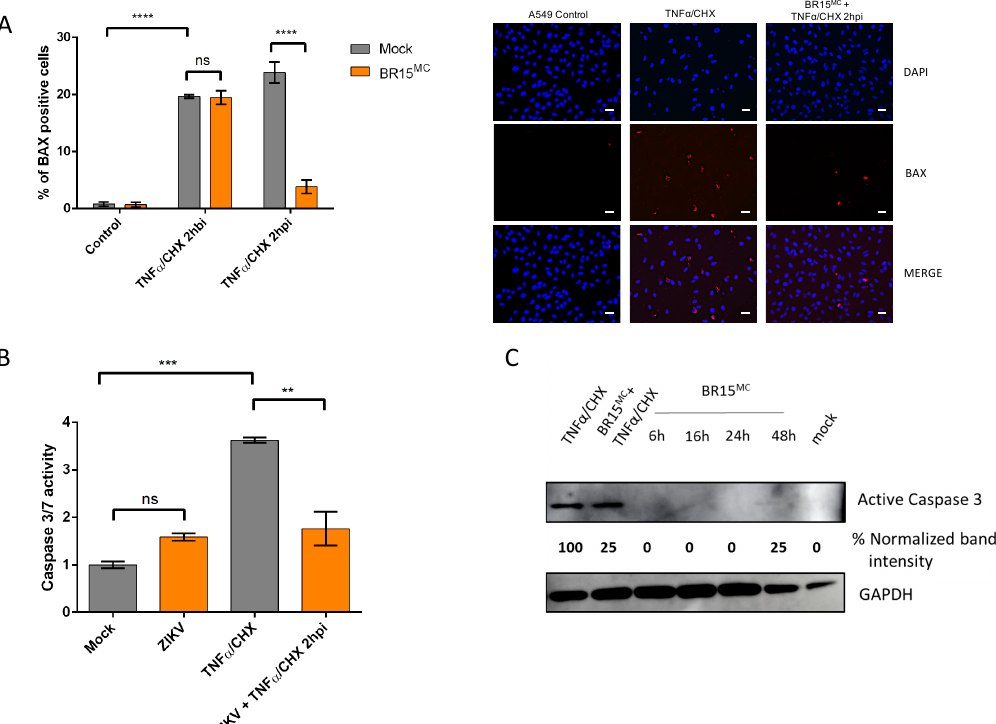
Figure 3. BR15 MC provides a protection against extrinsically induced cell death. A549 cells were infected with BR15 MC at MOI of 1 for 8 h and treated with TNF α and cycloheximide (TNF α / CHX) 2 h post infection (2 hpi) or 2 h before infection (2 hbi). ( A ) The percentage of A549 cells immunolabeled with anti-BAX antibody was enumerated from images representative of immunofluorescence observations (panels on the right, white scale bar: 10 µ m). ( B ) Caspase 3 / 7 activity was measured after TNF α / CHX treatment 2 hpi and normalized to mock treated and infected cells. ( C ) Immunoblot of active caspase 3 during TNF α treatment 2 hpi and infection time course with BR15 MC . Active caspase 3 band intensity was normalized with GAPDH. Western blotting (WB) is representative of three independent experiments. Values represent the mean and standard deviation of three independent experiments. Data were analyzed by a one-way ANOVA test with post-hoc Tukey’s test (** p < 0.01; *** p < 0.001, **** p < 0.0001, ns = not